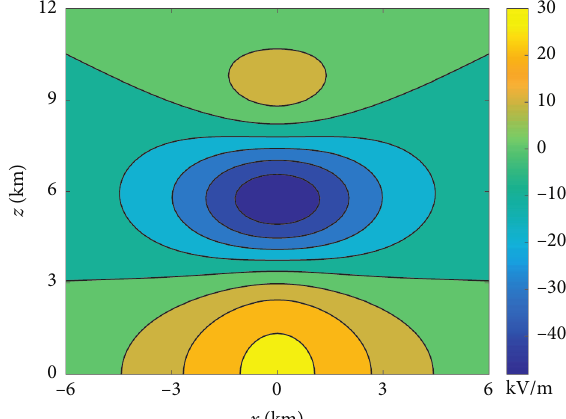
Figure 14: Contour of potential distribution on the longitudinal section while y � 2000m.